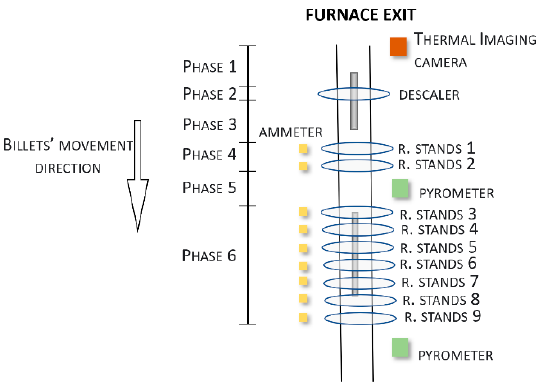
Figure 8. Original configuration of the plant (including details on the rolling mill phase).